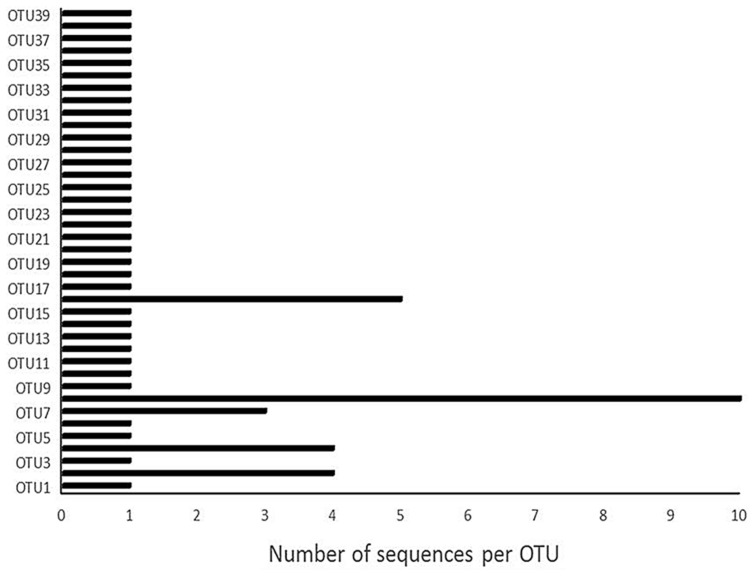
Operational Taxonomic Units (OTUs) and number of sequences per OTU.